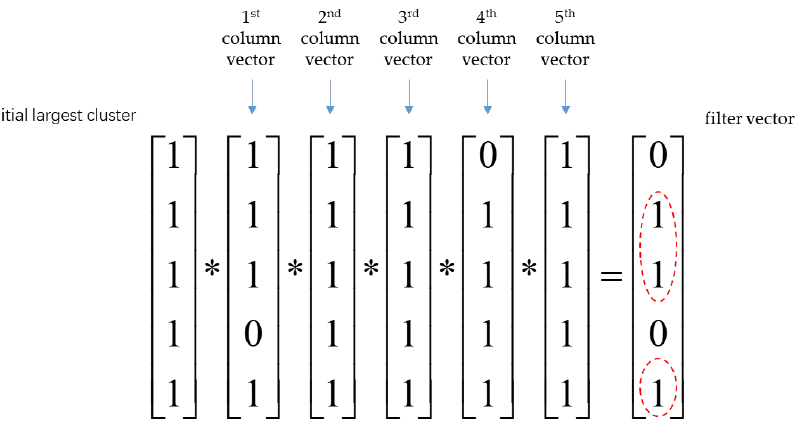
Figure 9. Filtering initial largest cluster